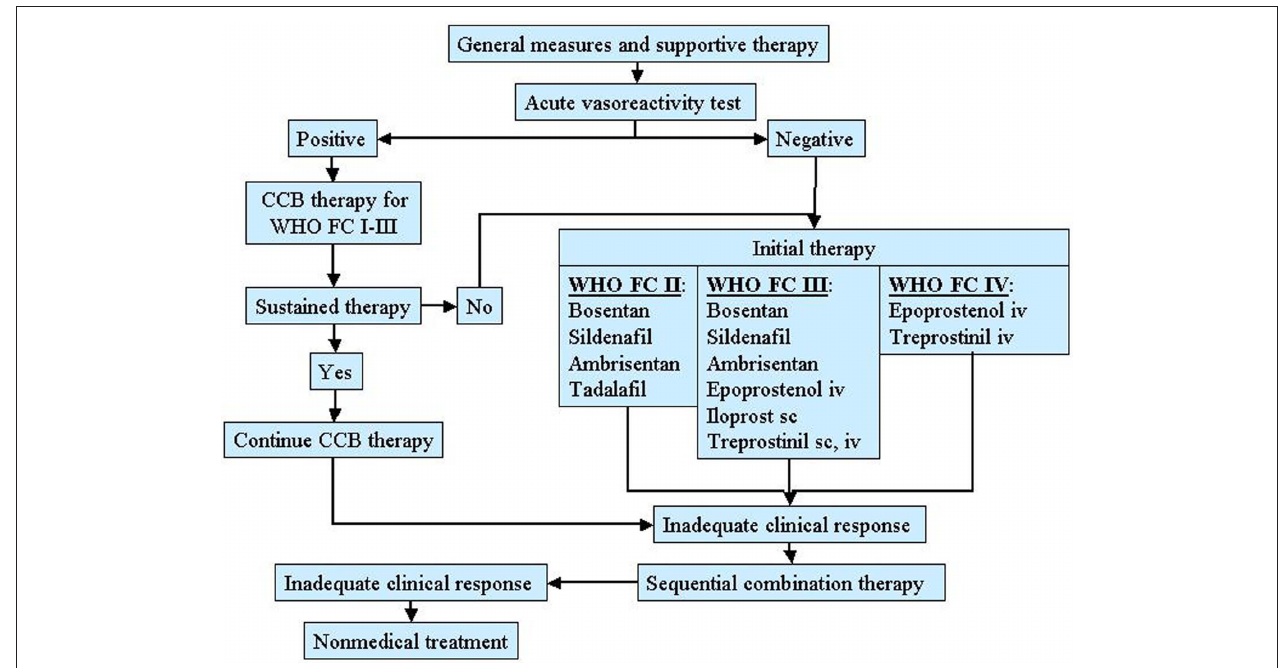
FIGure 2 | Therapeutic approach for pulmonary arterial hypertension (PAH) based on the WHO functional class. CCB, calcium